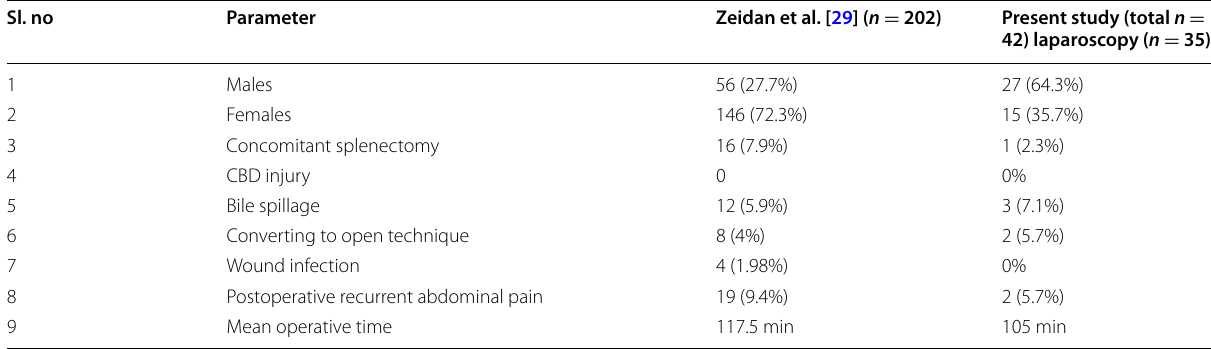
Our observations are similar to Zeidan et al. [29] though the sample size is very less